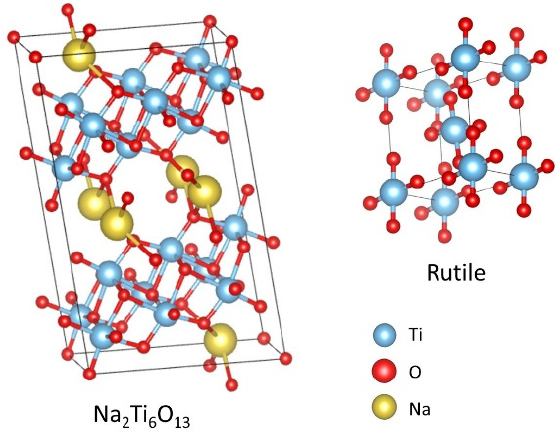
Figure 3. Crystal structure of NTO and rutile.